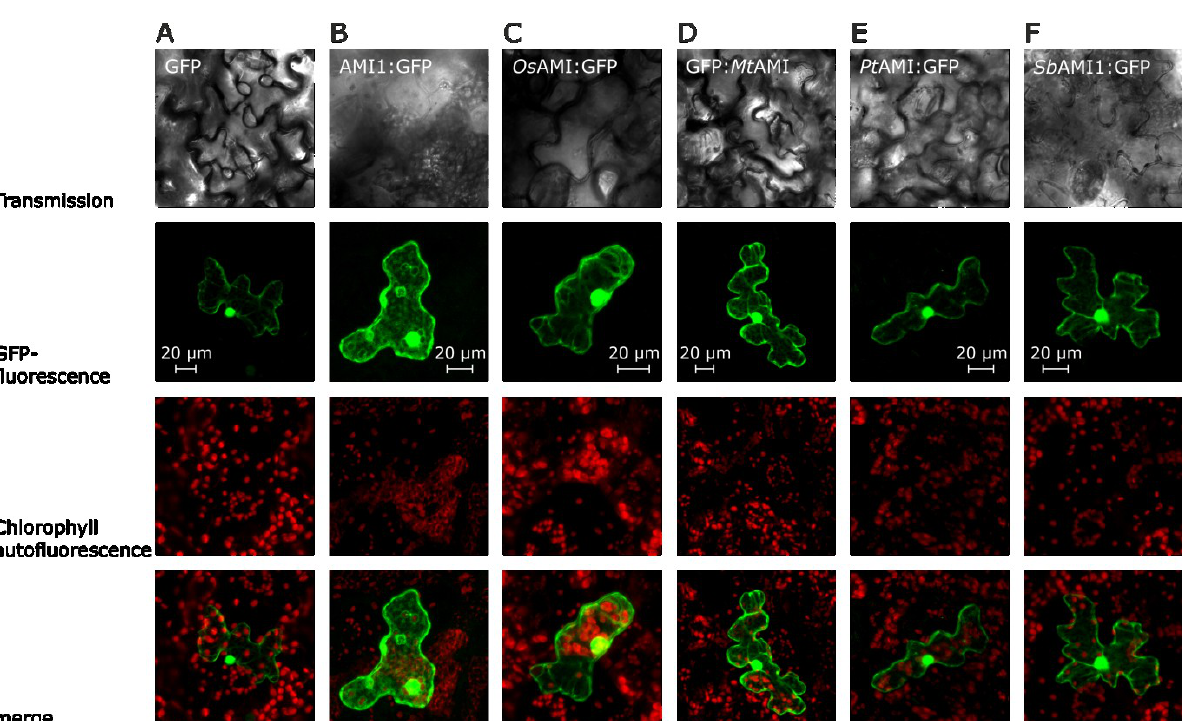
Figure 3. Localization of amidase GFP fusion proteins in epidermal cells of Arabidopsis thaliana . The images show typical results of confocal laser scanning microscopic studies, using differential emission light filter sets. The upper row provides transmission images, followed by the GFP channel (GFP-fluorescence), showing the fluorescence of the GFP-fluorophore between 500 and 530 nm. Next, the chlorophyll-autofluorescence is shown in a separate channel (650 to 798 nm). In the bottom row, an overlay of the fluorescence channels is depicted. ( A ) Transformation with an empty GFP-vector (pSP-EGFP), cytoplasmic control; ( B ) Transformation with an AMI1 : GFP construct from A. thaliana [31] (positive control); ( C ) Transformation of an epidermis cell with the Os AMI1:GFP construct; ( D ) Transformation with the chimeric GFP: Mt AMI construct; ( E ) Transformation with the Pt AMI:GFP vector; ( F ) Transformation of the Sb AMI1:GFP construct. Scale bars for each set of pictures are included in the